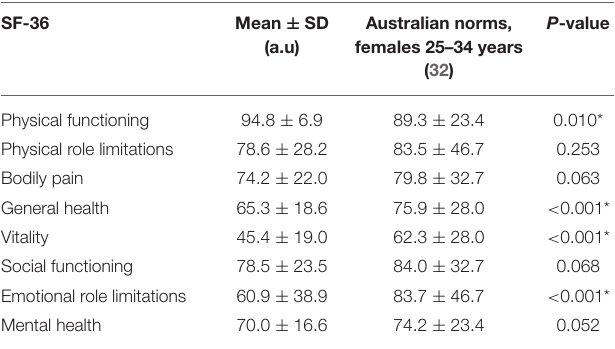
TABLE 2 | Postpartum well-being of women as measured through an SF-36 ( n = 121), compared with Australian female norms aged 25–34 years ( n = 2,182).